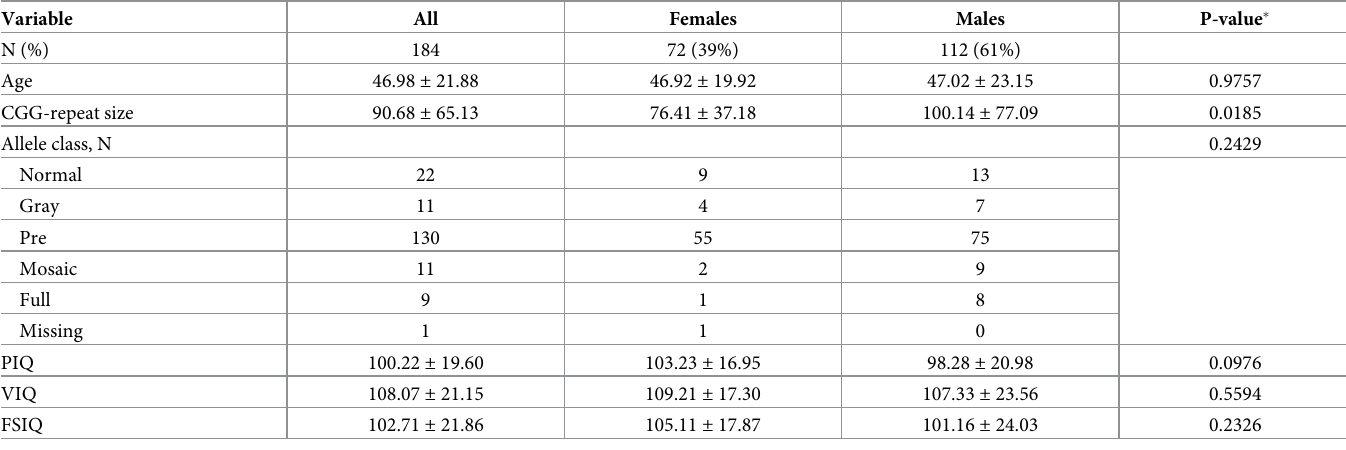
Table 1. Descriptive statistics of patient characteristics, by